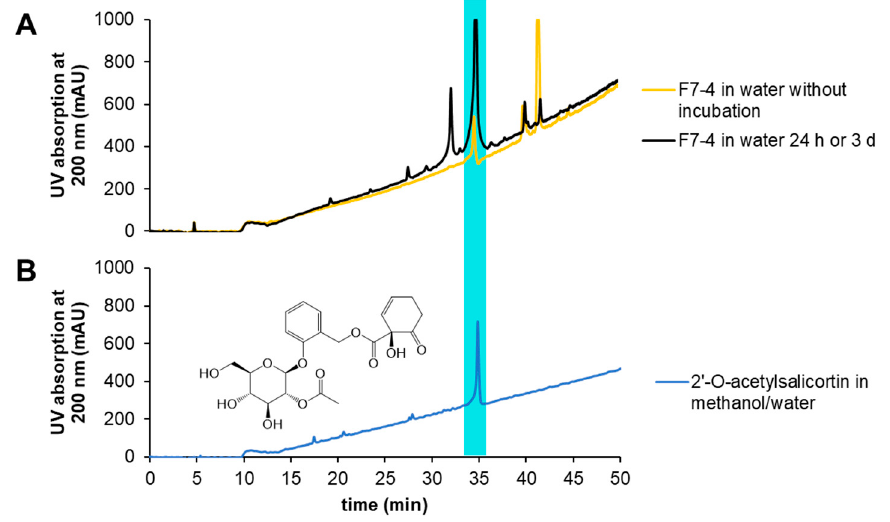
Figure 5. Analytical HPLC chromatograms of fraction F7-4 diluted in water before (( A ), yellow) and after (( A ), black) incubation in comparison to 2 ′ - O -acetylsalicortin ( 1 ) (( B ), turquoise).